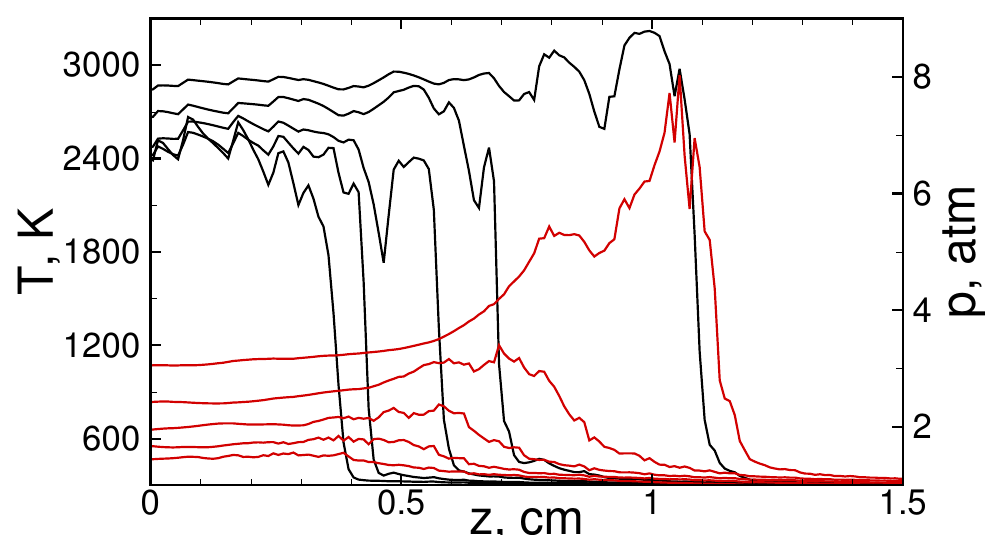
Figure 5. Temperature (black) and pressure (red) profiles in the fixed cross section at subsequent time instants (20, 25, 30, 35, and 40 µ s).